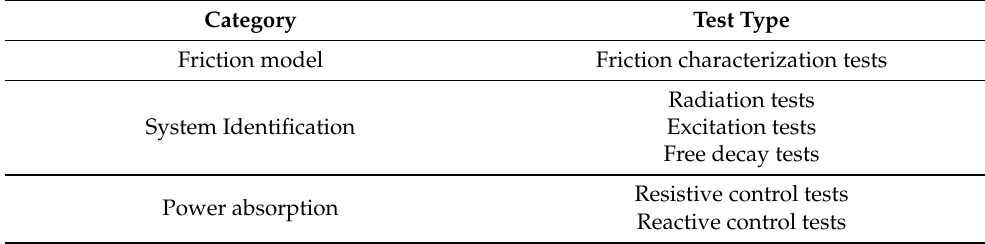
Table 1. Overview of the types of performed tests.